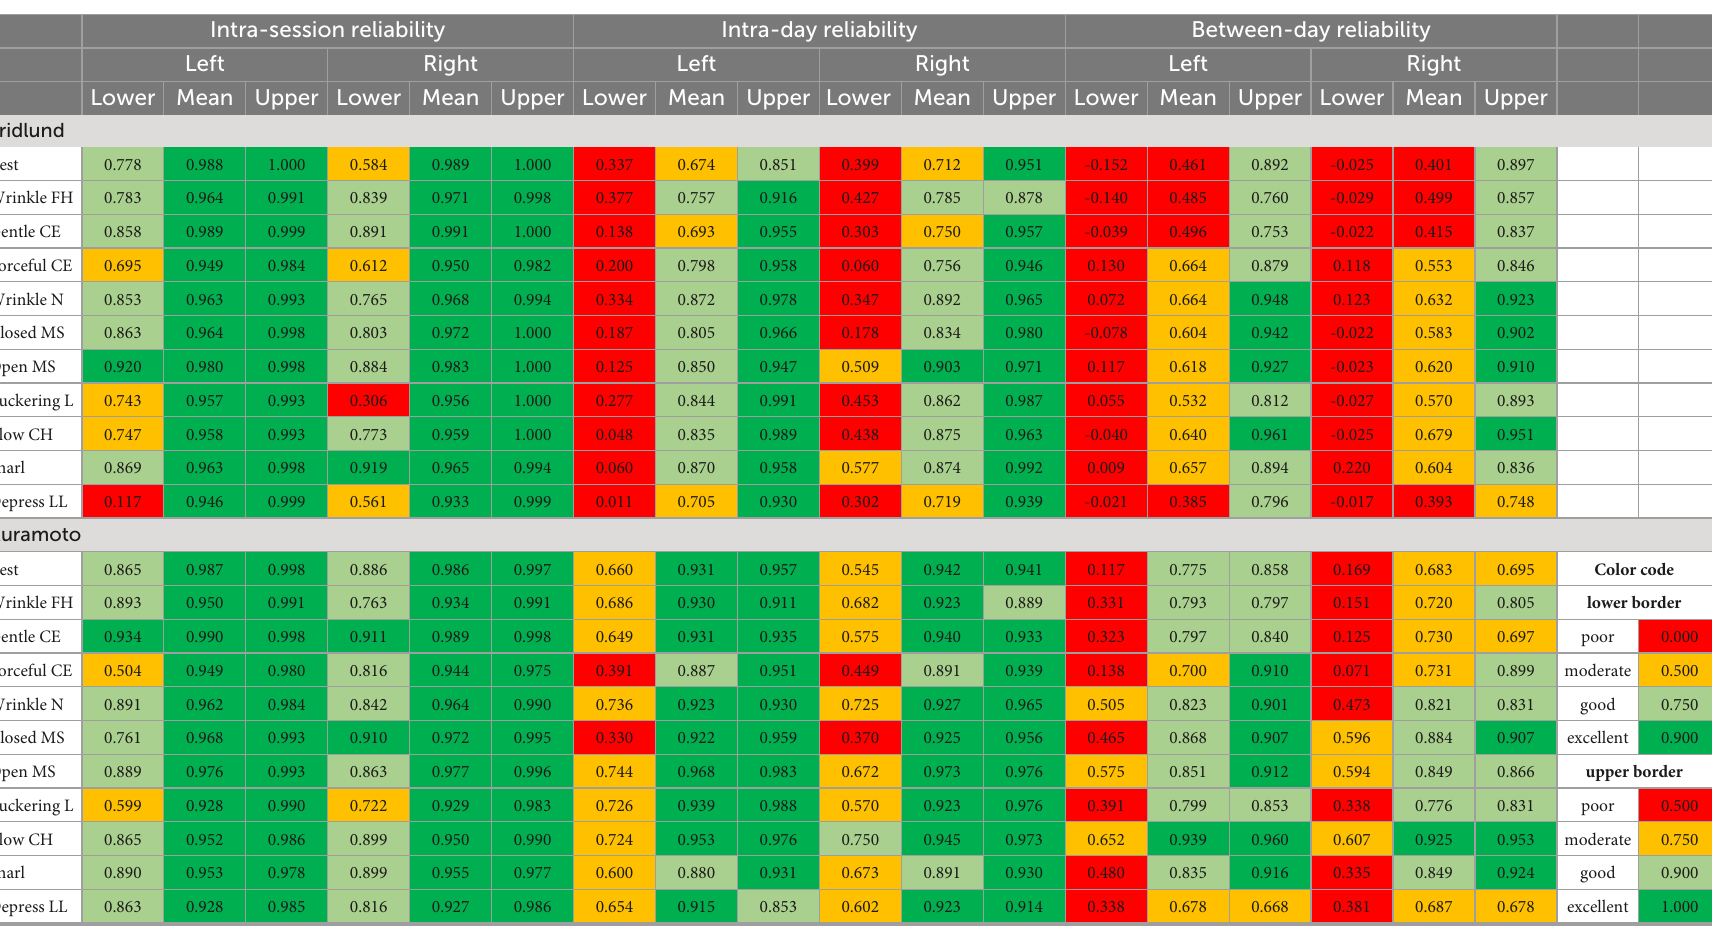
TABLE 2A Intraclass correlation coefficient (ICC) statistics: Test and re-test reliability of the surface EMG recordings during the different facial movement tasks for the Fridlund and the Kuramoto